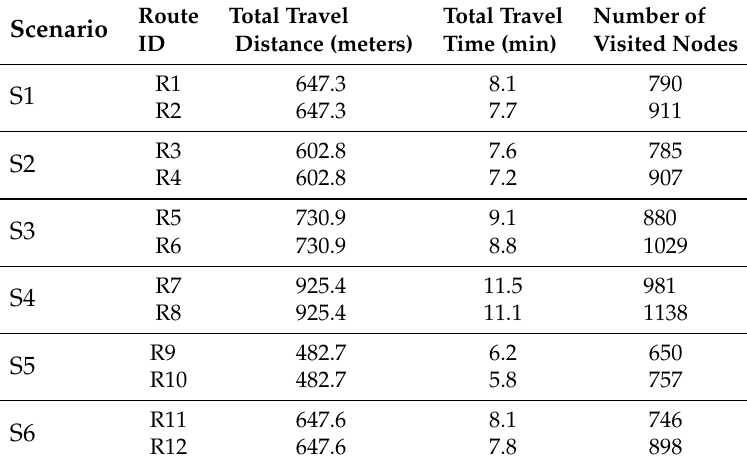
Table 2. Calculated results for Case 2.